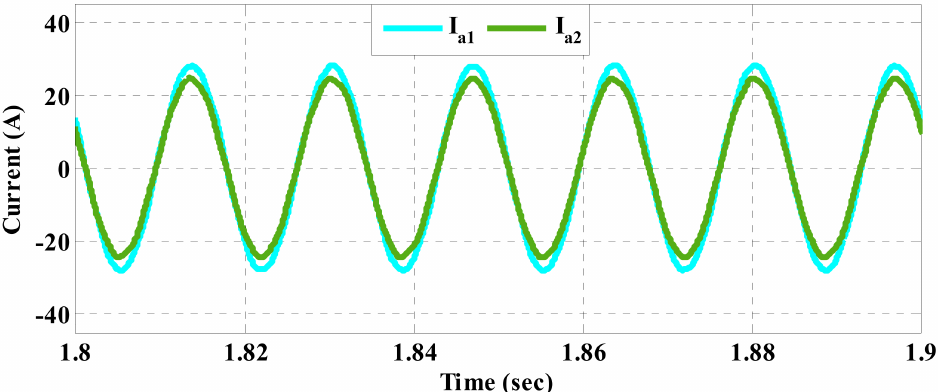
Figure 15. Injected currents of DGs to the microgrid based on the proposed control